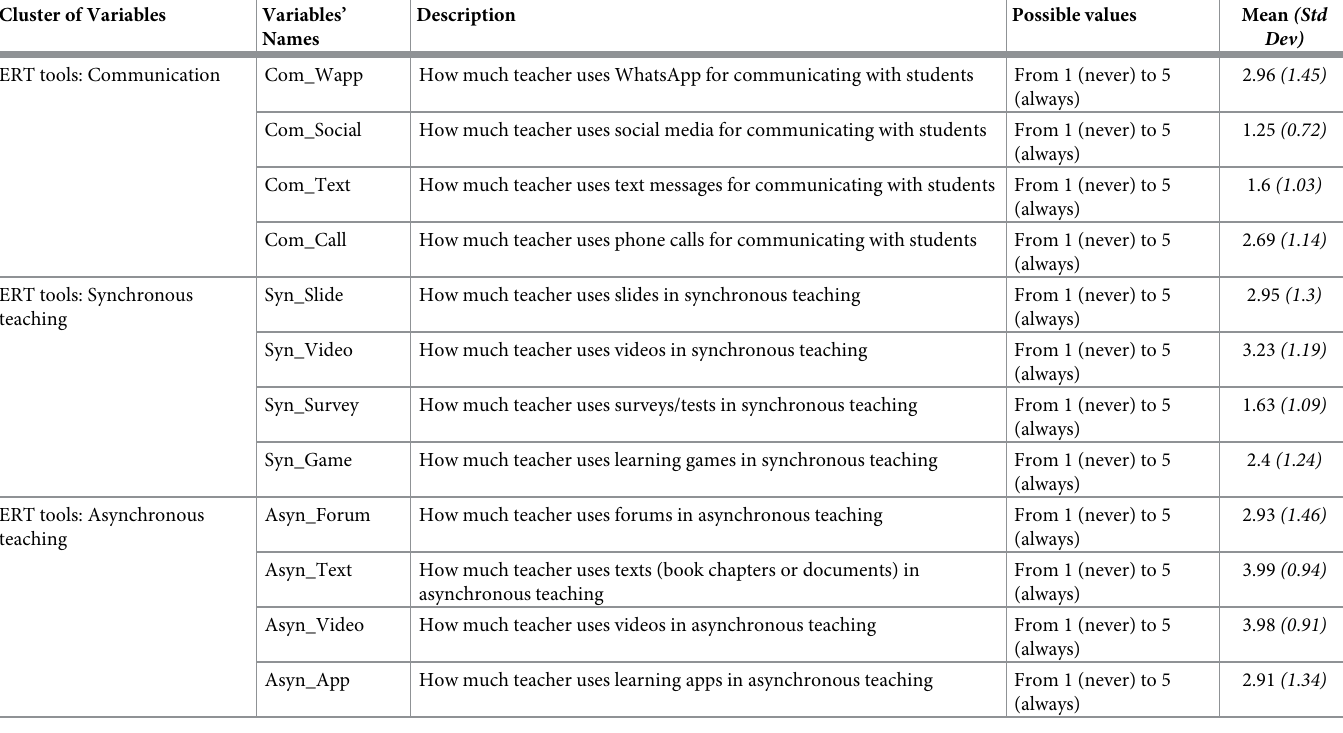
Table 1. Description and basic statistics of the variables adopted for Step 1 of LCA. Cluster of